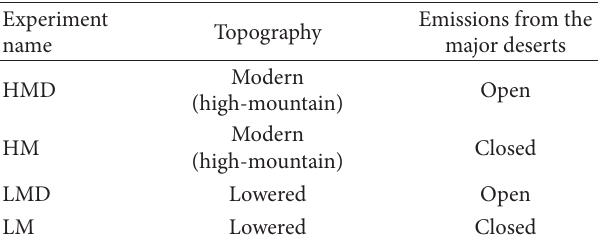
Table 1: Information on the topography and dust emissions in the